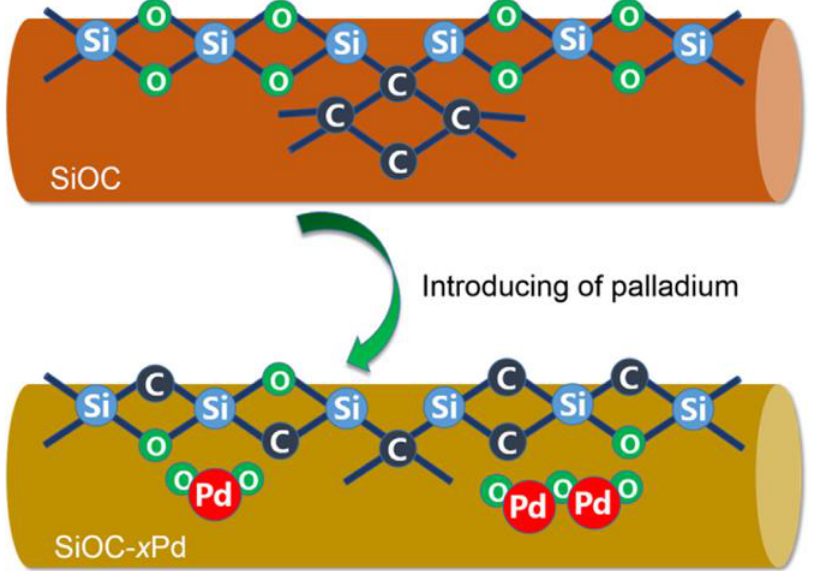
Figure 11. Schematic drawing of chemical composition on the surface of SiOC and SiOCxPd (Reprinted with permission from Ref. [72]. 2017 Elsevier).